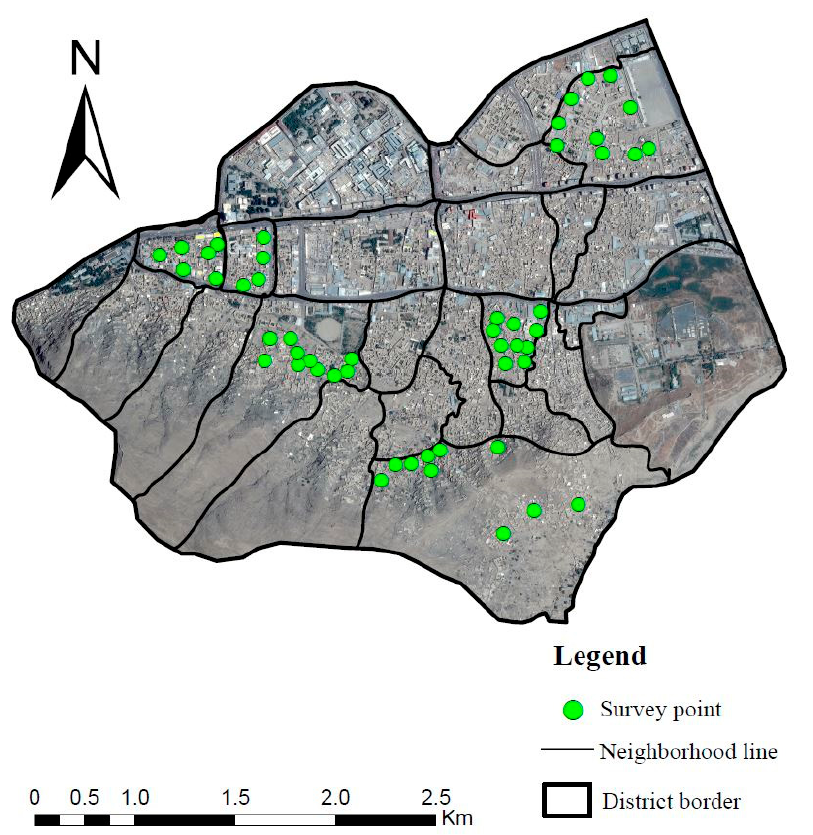
Figure 2. Map of District 1 with neighborhood boundaries and investigated sites.